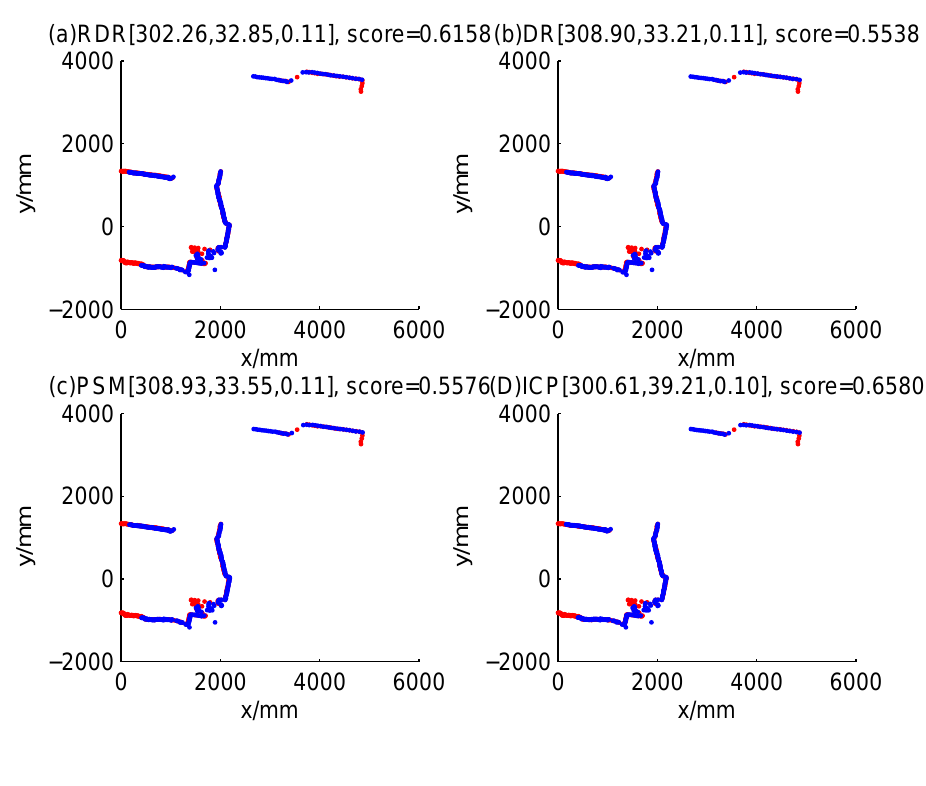
Figure 12. Robust dead reckoning result for Case 1b (time Step 3).